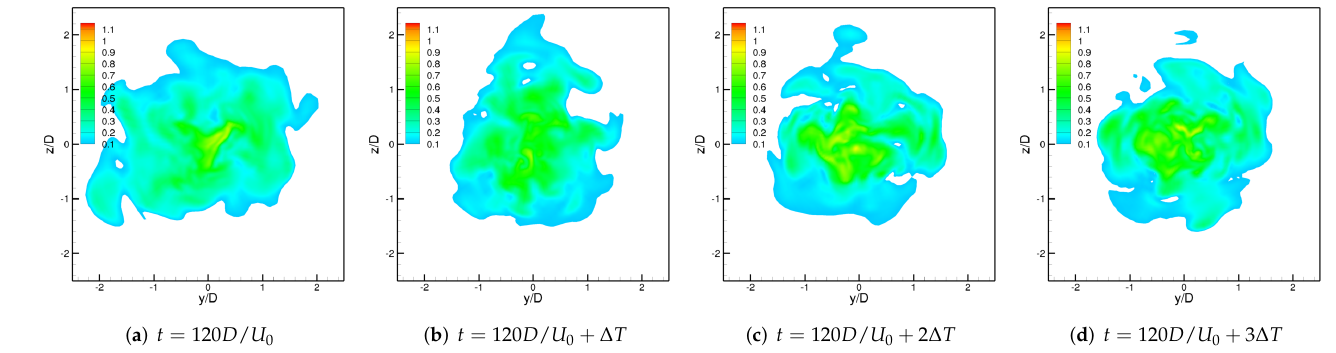
Figure 16. Contours of an instantaneous axial velocity U x / U 0 at the plane perpendicular to the jet axis x / D = 9 for the case E − Cyl − Ti 1.0